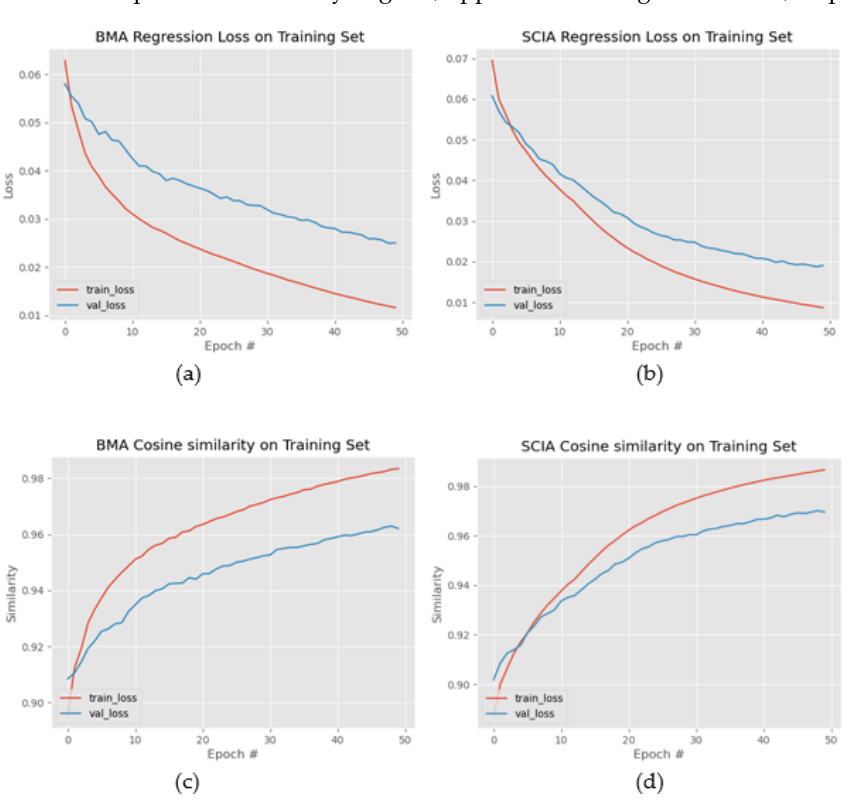
Figure 14. Training and validation bounding box regression loss as a function of the number of epochs for BMA ( a ) and SCIA ( b ), with cosine similarity as a function of the number of epochs for BMA ( c ) and SCIA ( d ).